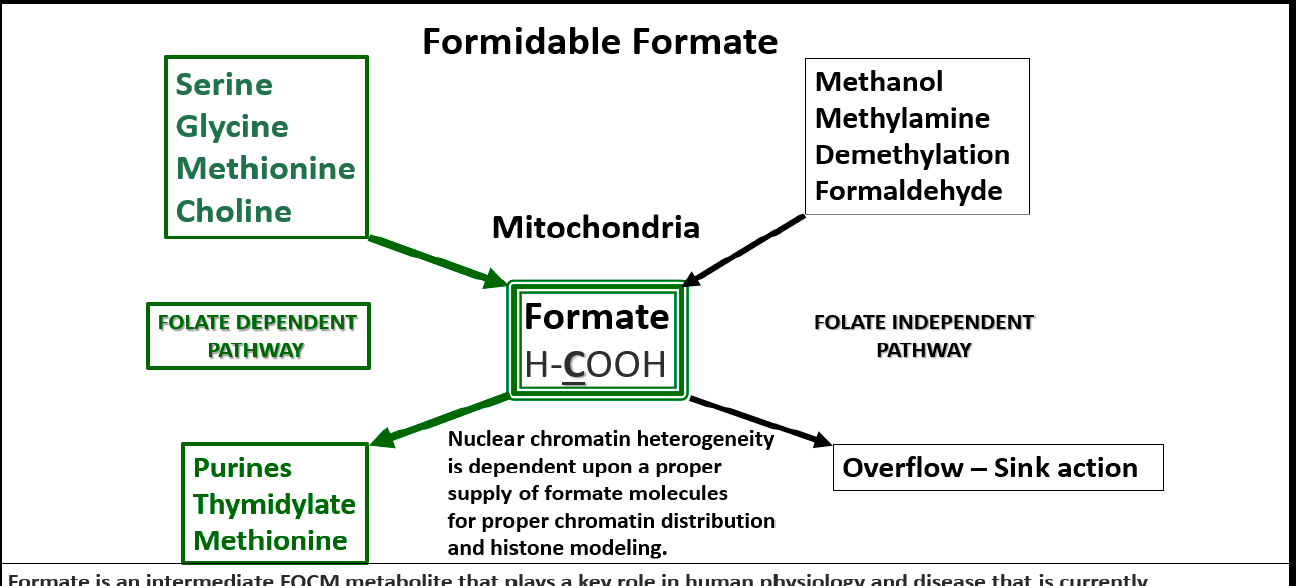
Figure 4. Formate Plays a Central and Formidable Role in Providing Proper Nucleus Function and Structure. Serine, glycine, methionine and choline are also necessary components to fulfill proper mitochondrial function to the nucleus in order to produce purines, thymidylate and methionine to fulfil their role in the nucleus. This figure depicts the importance of the folate dependent pathway (green coloring) for formate synthesis in the mitochondria and the central role for the formidable formate to be utilized by the nucleus for proper chromatin modeling. Note the bold and underlining of the important carbon unit in the chemical formula for formate. Also, note the folate independent pathway on the right-hand side of this figure. The concept for this slide design was derived from reference [35].